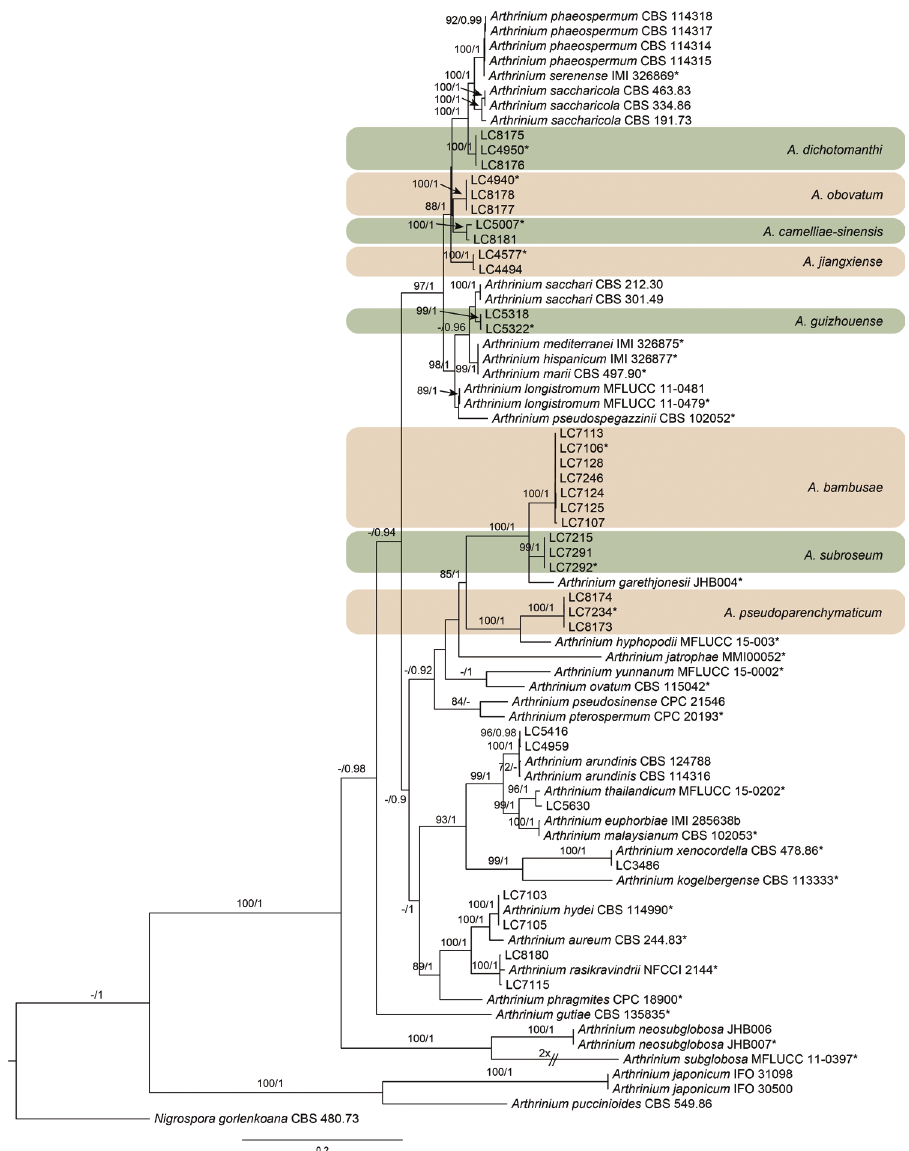
Figure 1. Phylogenetic tree based on the combined ITS, TEF1 and TUB2 sequences alignment gener- ated from a Maximum likelihood phylogenetic analysis. Bootstrap support values (>70%) and posterior probabilities (>0.9) are given at the nodes (ML/PP). The tree is rooted with Nigrospora gorlenkoana CBS 480.73. The novel species were highlighted (* indicates the ex-type